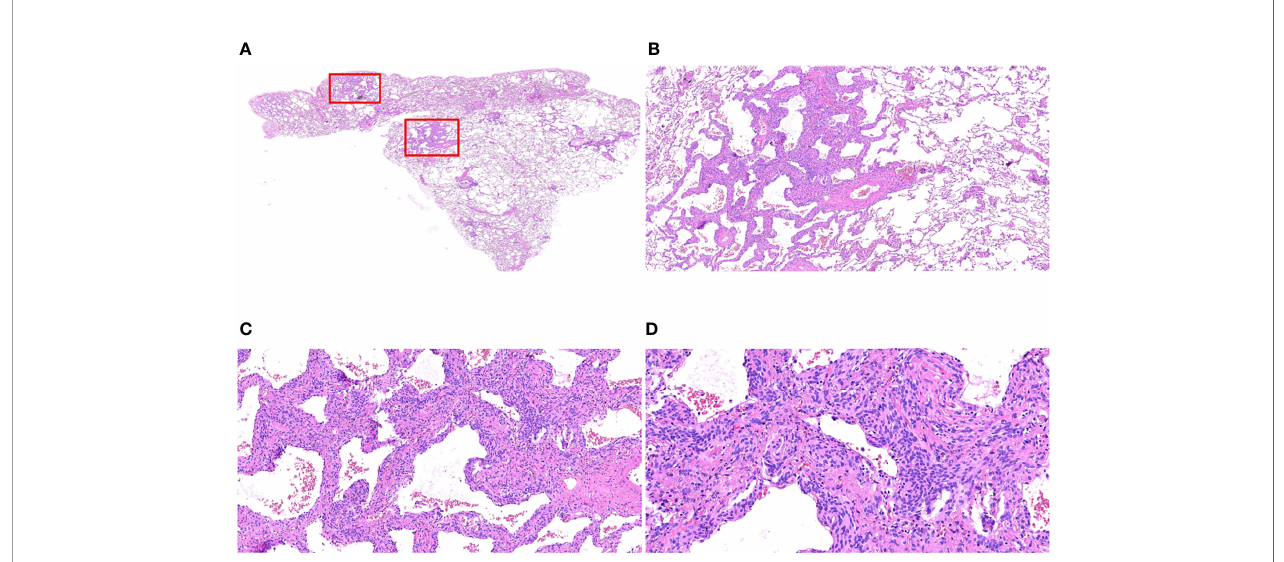
FIGURE 3 | Morphological characteristics of postoperative paraf fi n sections of MPMNs. (A) Paraf fi n section HE x7.2 with an open alveolar cavity, uniform distribution of fi ne bronchi, several areas of widened alveolar septa and dense cells (shown in the red box) still clearly demarcated from the surrounding lung tissue, without an envelope. (B) x40 HE shows widened alveolar septa, lesion cells growing along the alveolar septa and an open air cavity. (C) HE x100 lesion cells partially growing around the blood vessels. (D) HE x200 shows that the lesion cells are round or ovoid, with relatively normal morphology, abundant cytoplasm, unclear cell demarcation, light stained nuclei with delicate chromatin and without